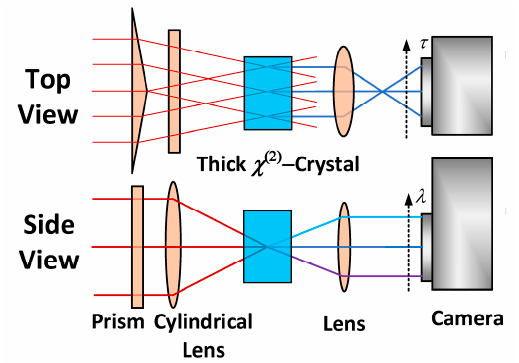
Figure 3. Schematic of the GRENOUILLE beam geometry. Top view: Time-to-space encoded scanning geometry. Side view: sum-frequency spectrum generation by angle-independent